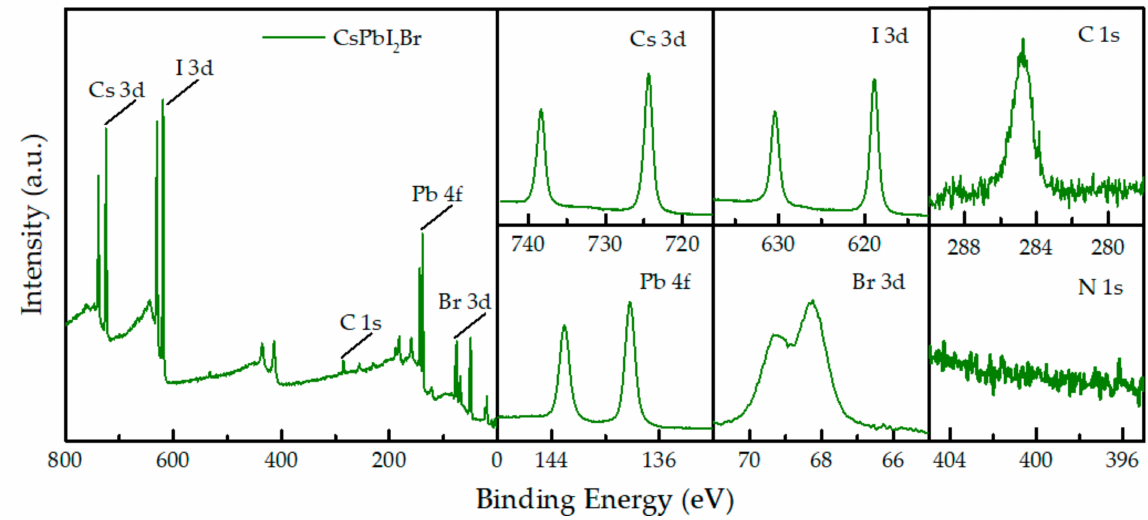
Figure 2. X-ray photoelectron spectroscopy of the perovskite films prepared at 35 ◦ C in ambient